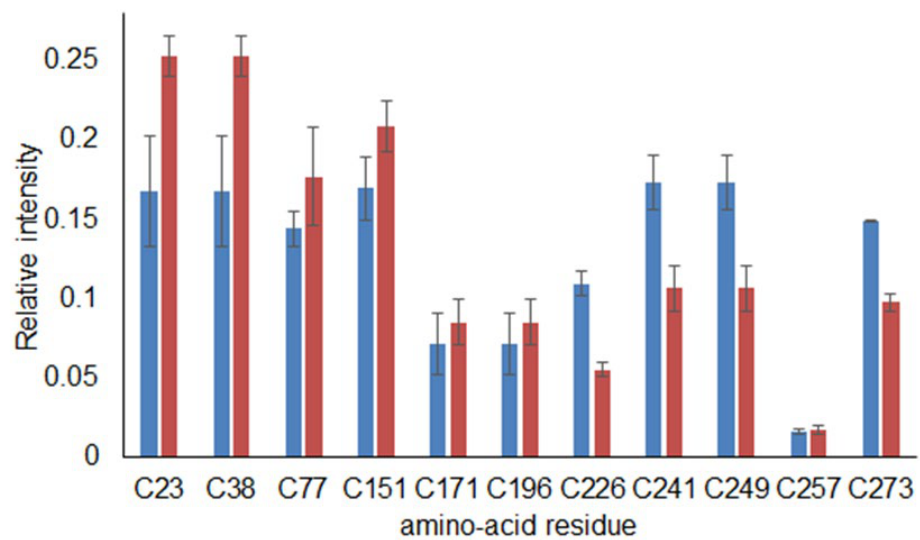
Figure 3. Relative intensities of alkylated peptides containing free cysteine without (blue) and with (red) incubation with BP-Cx-1 determined by LC-MS.